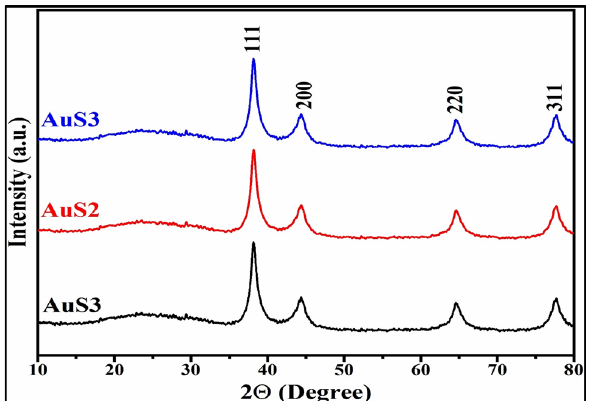
Figure 6. X-ray Diffraction for AuNPs using essential oil of C . flexuosus from different altitudes of Palampur (AuS1) (a), Haryana (AuS2) (b) and Dehradun (AuS3) (c).